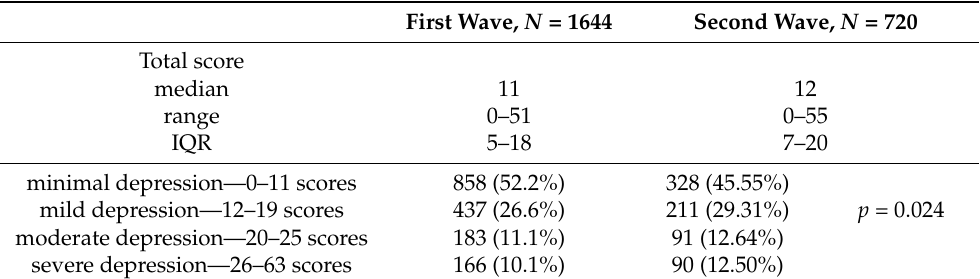
Beck Depression Inventory score during the first and second wave of the COVID-19 pandemic.